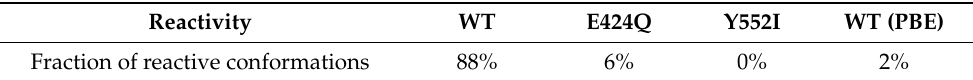
Table 2. Fractions of the reactive species obtained in the analysis of the Laplacian of electron density of the sets of 50 frames from QM/MM MD trajectories at the ES configuration for the WT, E424Q and Y552I species calculated at the PBE0 level and for the ES WT complex calculated at the PBE level. Reactivity WT E424Q Y552I WT (PBE) Fraction of reactive conformations 88% 6% 0%